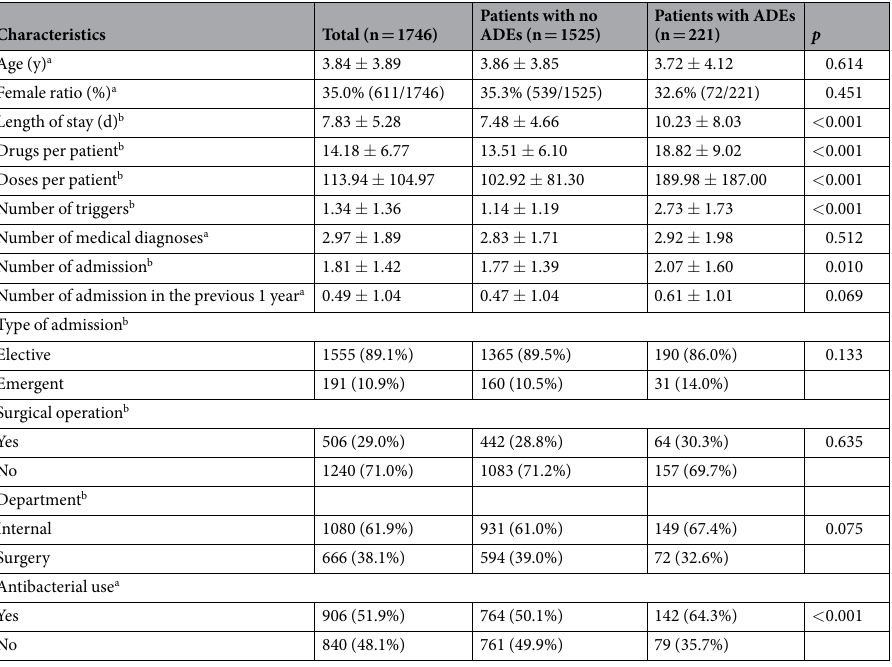
Table 1. Characteristics of Patients with ADEs and with no ADEs. Chi-square test or t-test: a p > 0.05, b p <